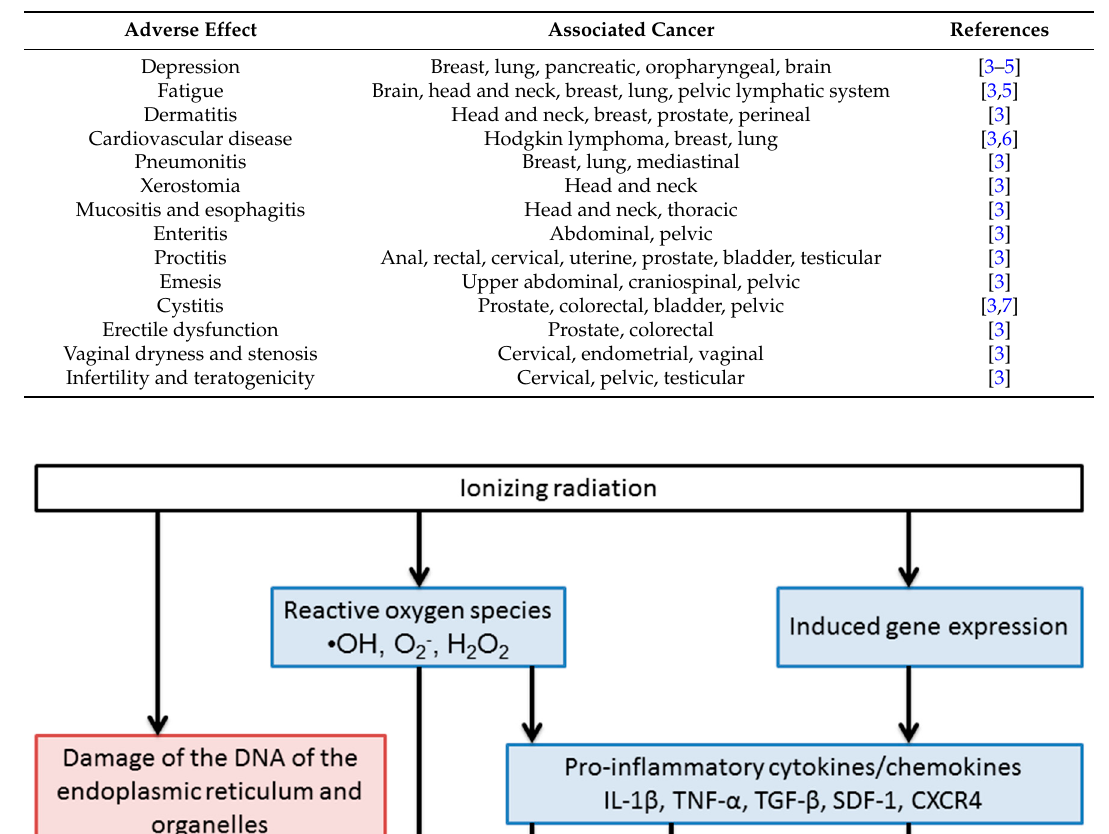
Table 1. List of adverse effects associated with radiation therapy and the associated cancers [3].